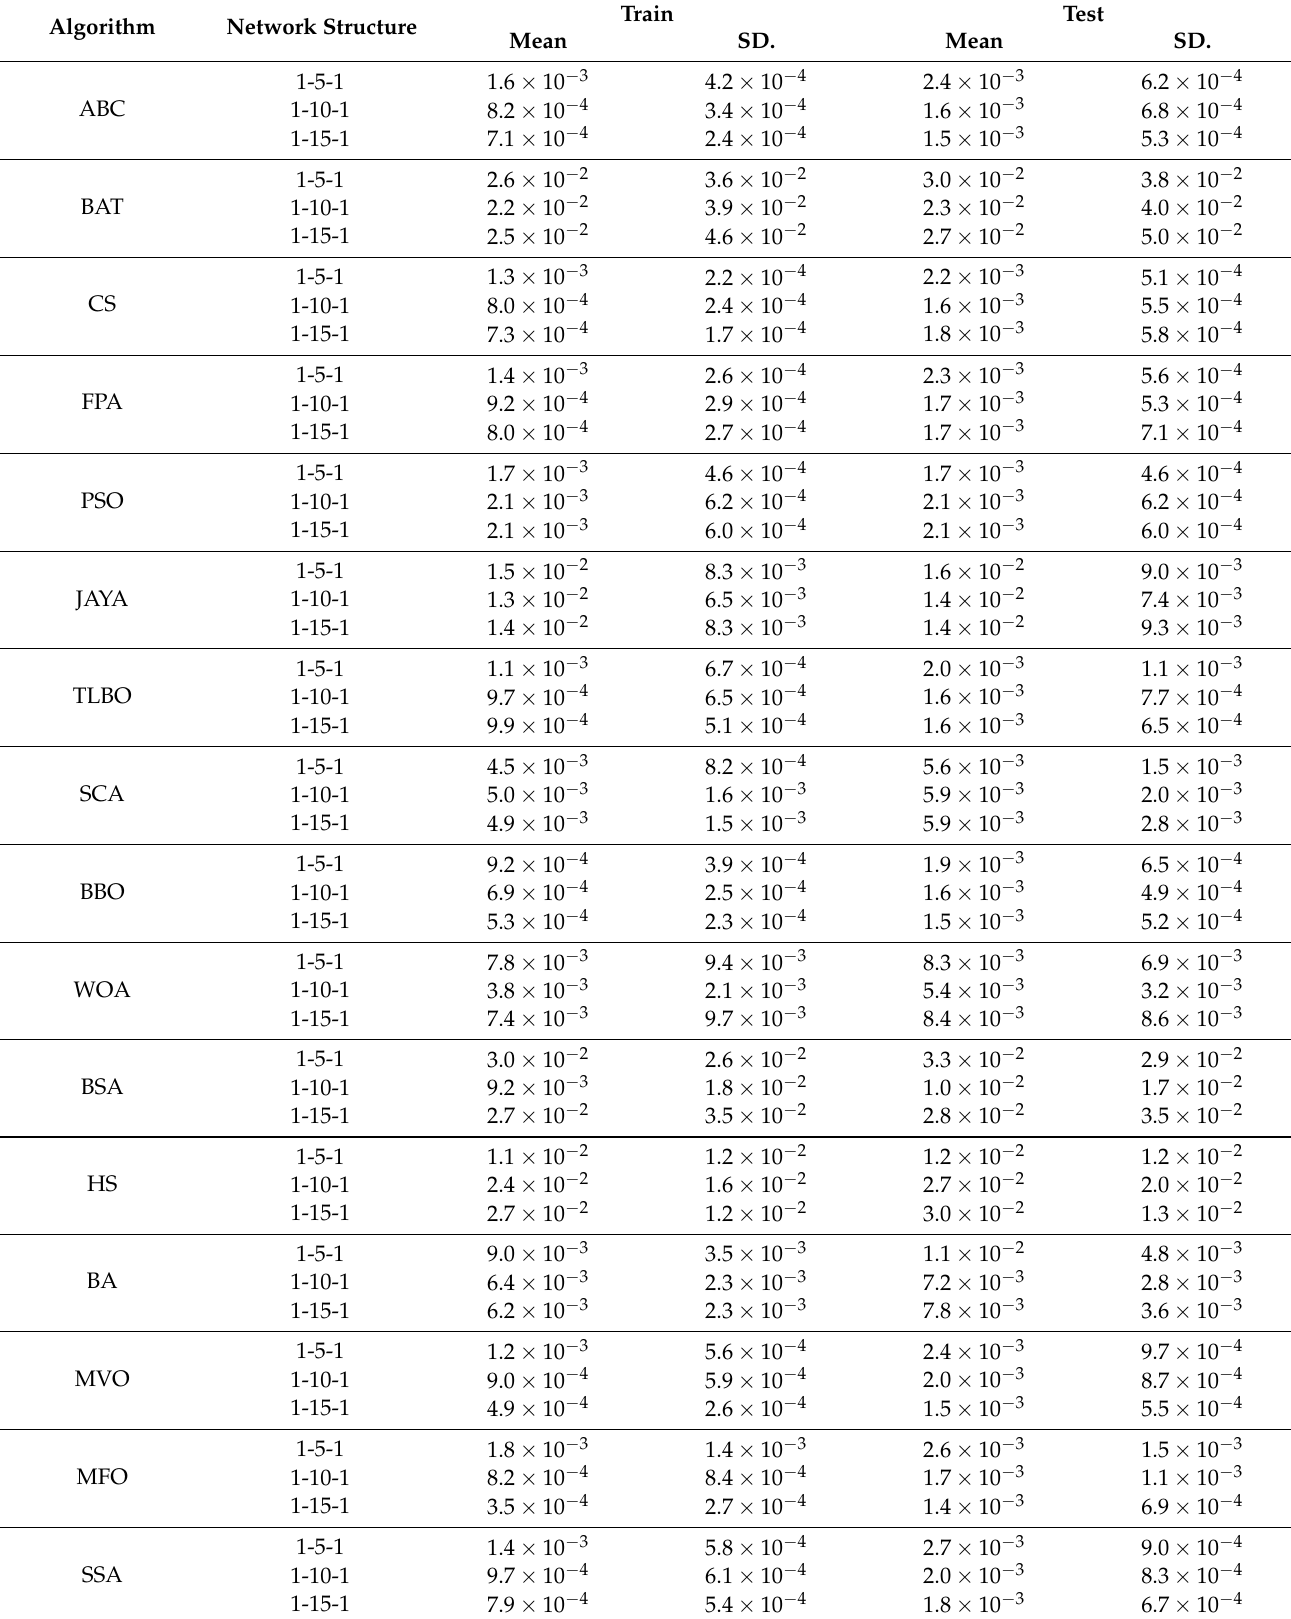
Table 2. The results obtained by using the metaheuristic algorithms for S 1